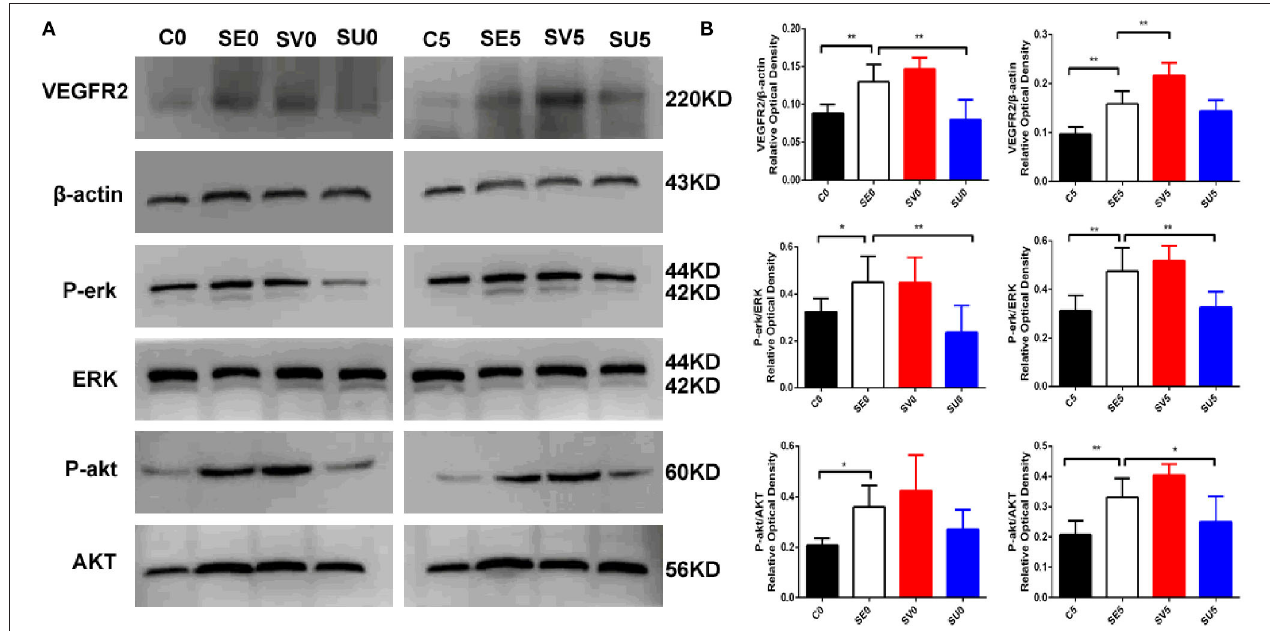
FIGURE 5 | Western blotting results showing the effects of VEGF regulation in different phases after SE on downstream signaling pathways. (A) Representative results with the corresponding antibodies. VEGFR2, P-akt, P-erk, AKT and ERK expression levels in the hippocampi of SE rats following regulation of VEGF in different phases after SE. (B) Quantitative analyses of the protein expression level in each group. The relative optical densities of VEGFR2, P-erk and P-akt were upregulated post-SE * P < 0.05, ** P < 0.01, n = 6 for each group. C, control; SV, VEGF injection; SU, application of a VEGFR2